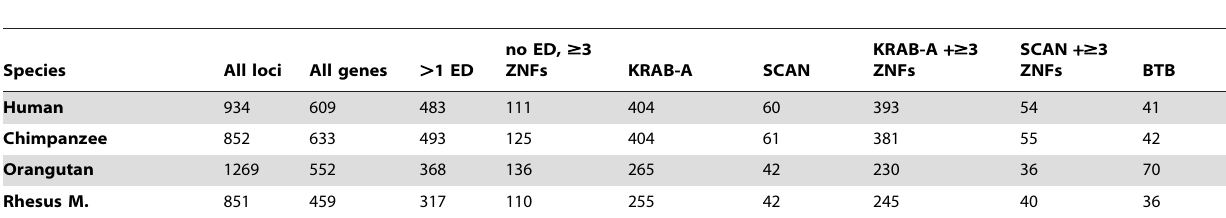
Table 1. Total number of KZNF loci, putative protein coding genes, and genes having certain domain compositions identified in four primate species.